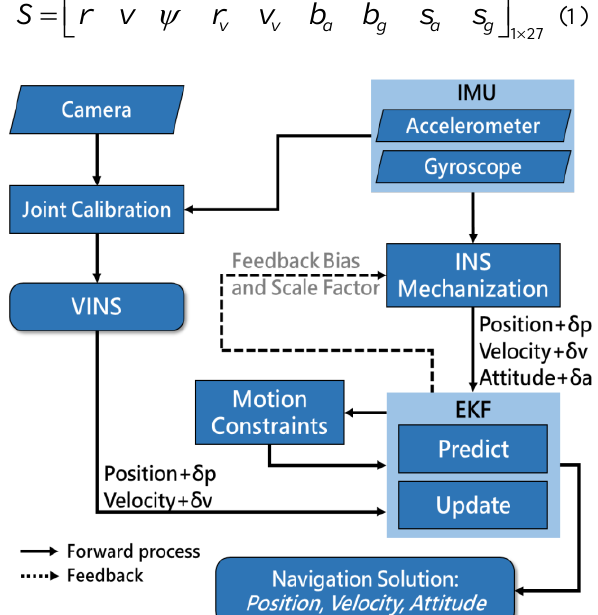
Figure 1. The proposed VINS aided INS integration scheme Modern people rely on smartphones to provide sufficient location services for GNSS navigation support in outdoor scenarios. Due to the limitations of smartphone sensors, integrated navigation solutions relied on low-cost inertial